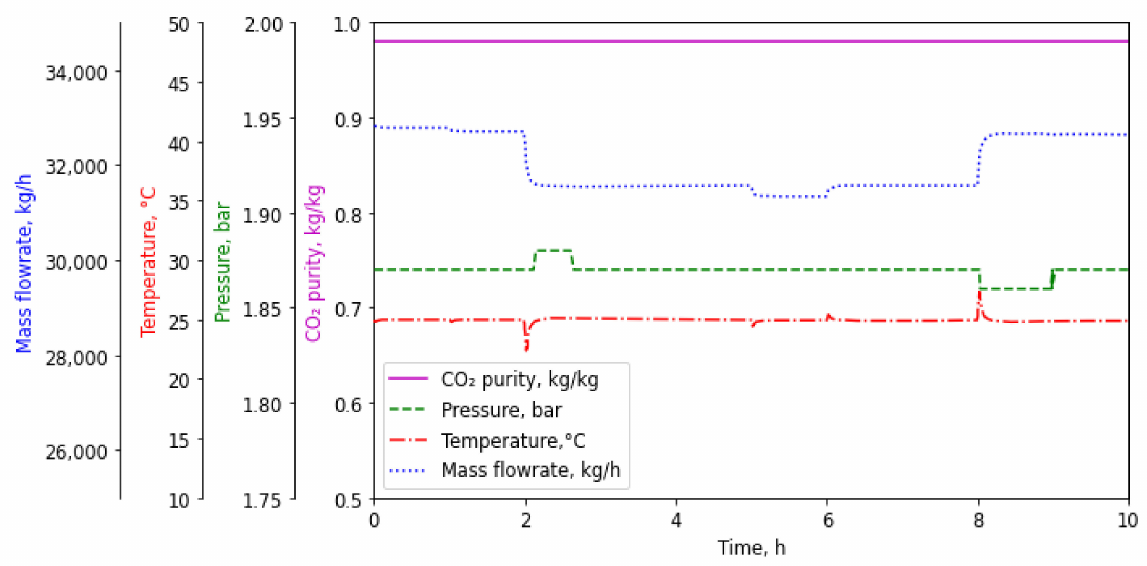
Figure 14. Desorber parameters during hydrogen tracking